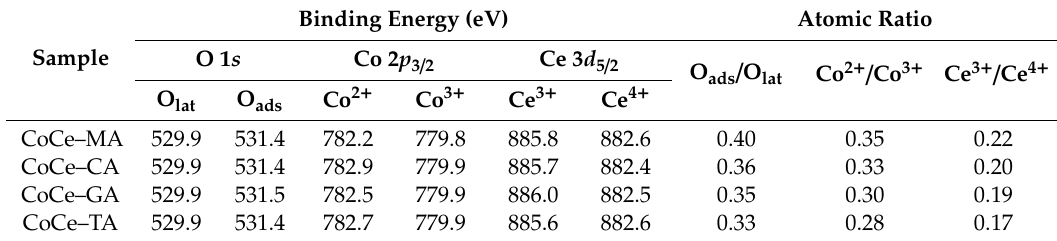
Table 4. XPS results of the CoCe–X